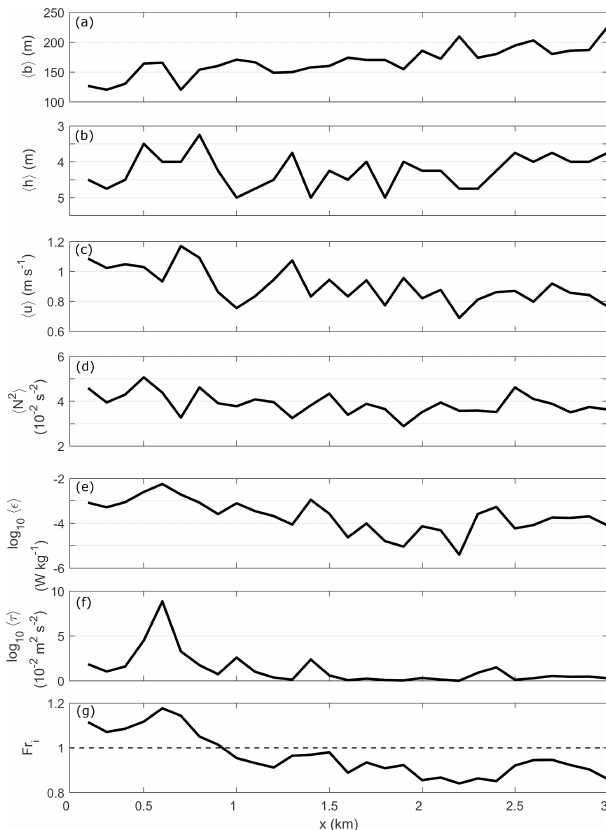
Figure 6. The evolution of plume-averaged quantities with distance from tailrace discharge point. (a) Plume width (cid:104) b (cid:105) , (b) surface layer thickness (cid:104) h (cid:105) , (c) along-channel velocity (cid:104) u (cid:105) , (d) stratification (cid:104) N 2 (cid:105) , (e) dissipation rate (cid:104) (cid:15) (cid:105) , (f) internal turbulence stress (cid:104) τ (cid:105) and (g) in- ternal Froude number ( Fr i ). The dashed line in panel (g) is the crit- ical value Fr i = 1. Each term was averaged over the depth of the surface layer ( h ), defined as the distance between the surface and depth of the maximum N 2 value. These values are from one along- channel transect on 7 March 2016 and representative of the plume behavior observed during all